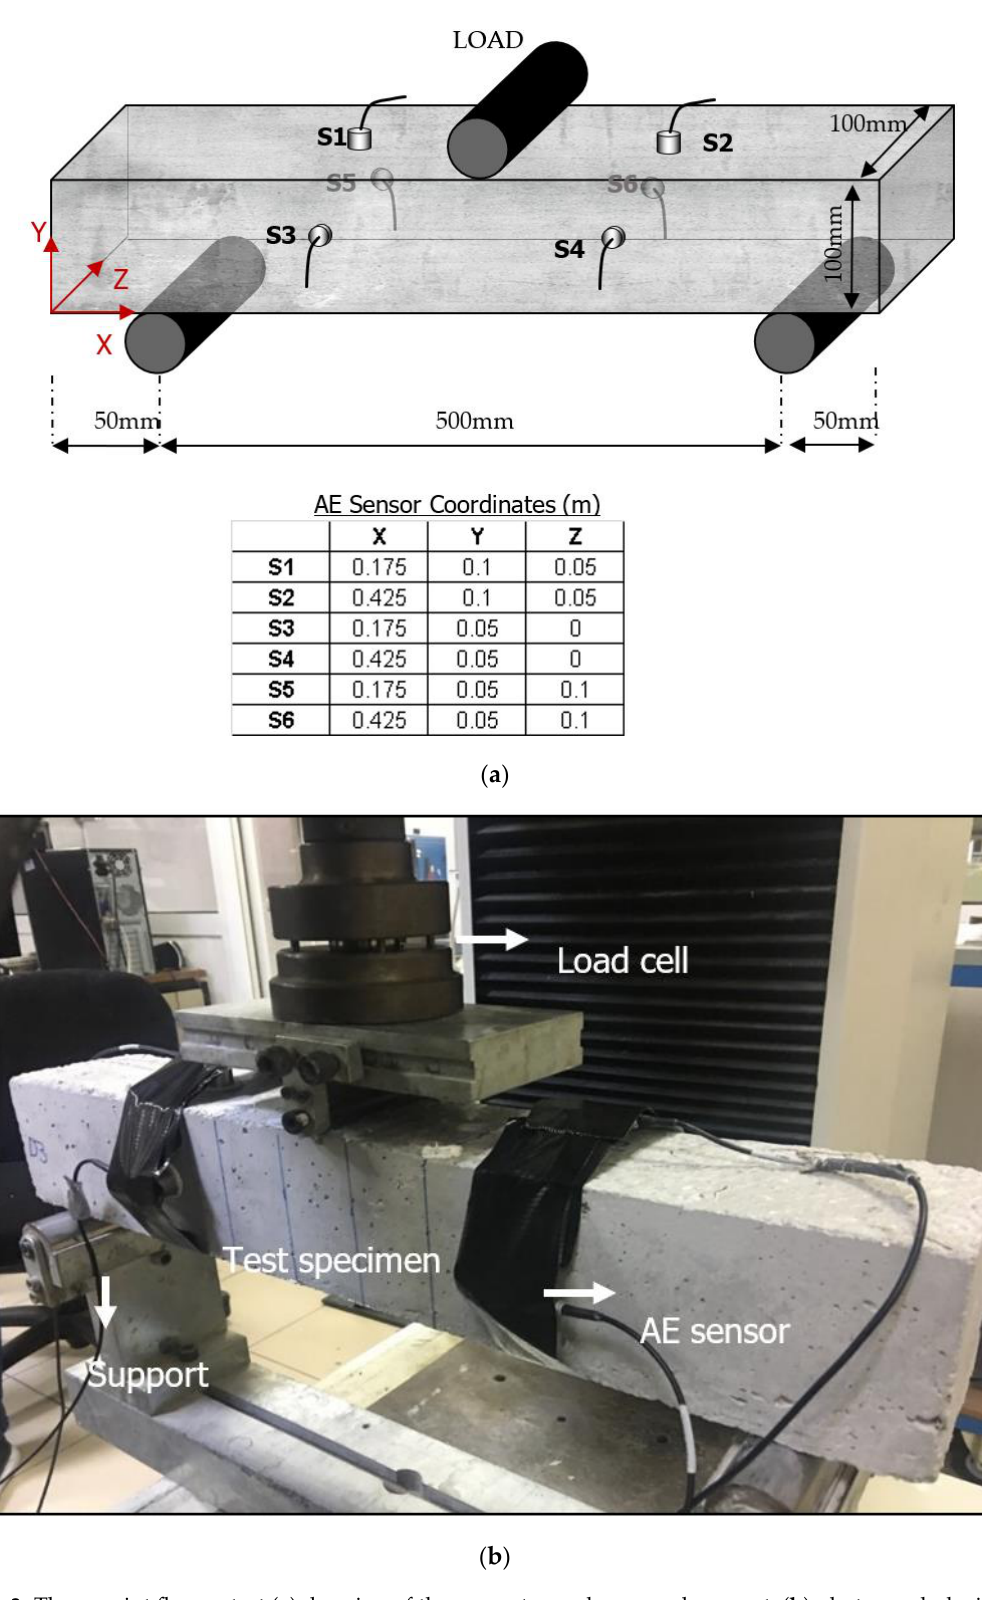
Figure 3. Three-point flexure test ( a ) drawing of the geometry and sensor placement, ( b ) photograph during test.